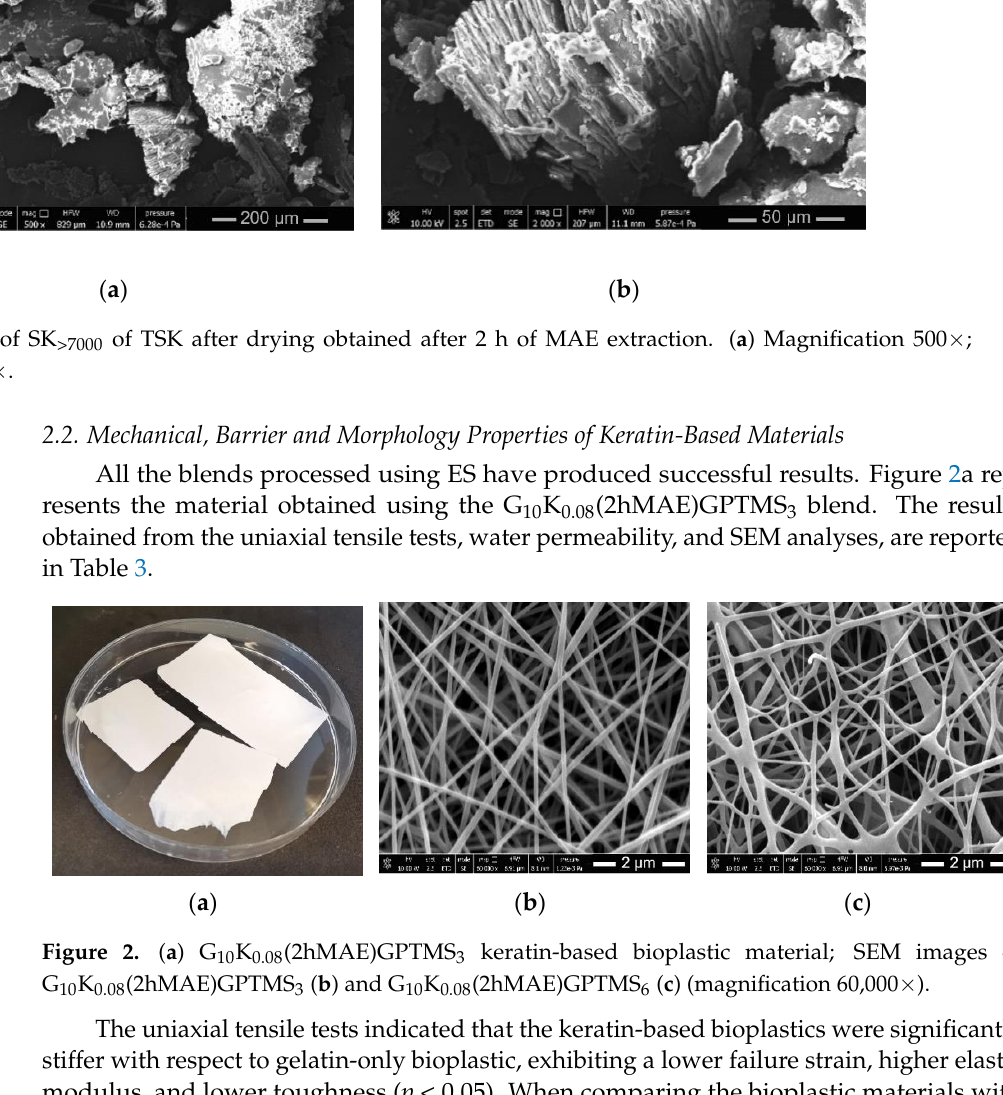
Figure 2. ( a ) G 10 K 0.08 (2hMAE)GPTMS 3 keratin-based bioplastic material; SEM images of G 10 K 0.08 (2hMAE)GPTMS 3 ( b ) and G 10 K 0.08 (2hMAE)GPTMS 6 ( c ) (magnification 60,000×).